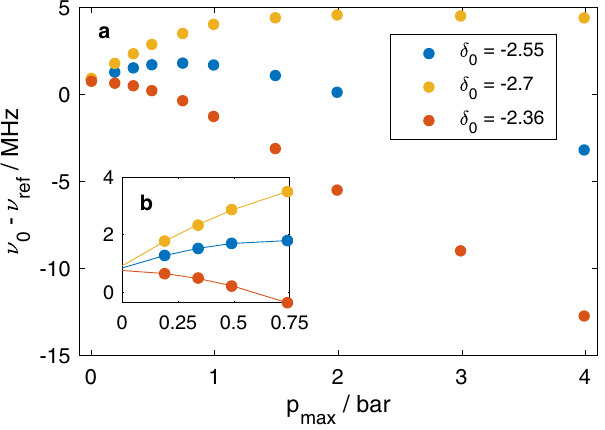
Fig. 3 Determination of the frequency of the Q(1) 1-0 line of H 2 . a Inferred ν p max considered for the global 0 as a function of the maximum pressure fi tting. The collisional parameters are fi xed to ab initio parameters except δ fi xed to the three different values speci fi ed in the legend, 0 , which is generating the three trajectories shown here. b Zoomed-in view of the low- pressure range together with parabolic extrapolations (lines) to p max = 0. The vertical axis reports the difference between the fi tted ν 0 and the ab initio value ν ref calculated by Komasa et al. 4